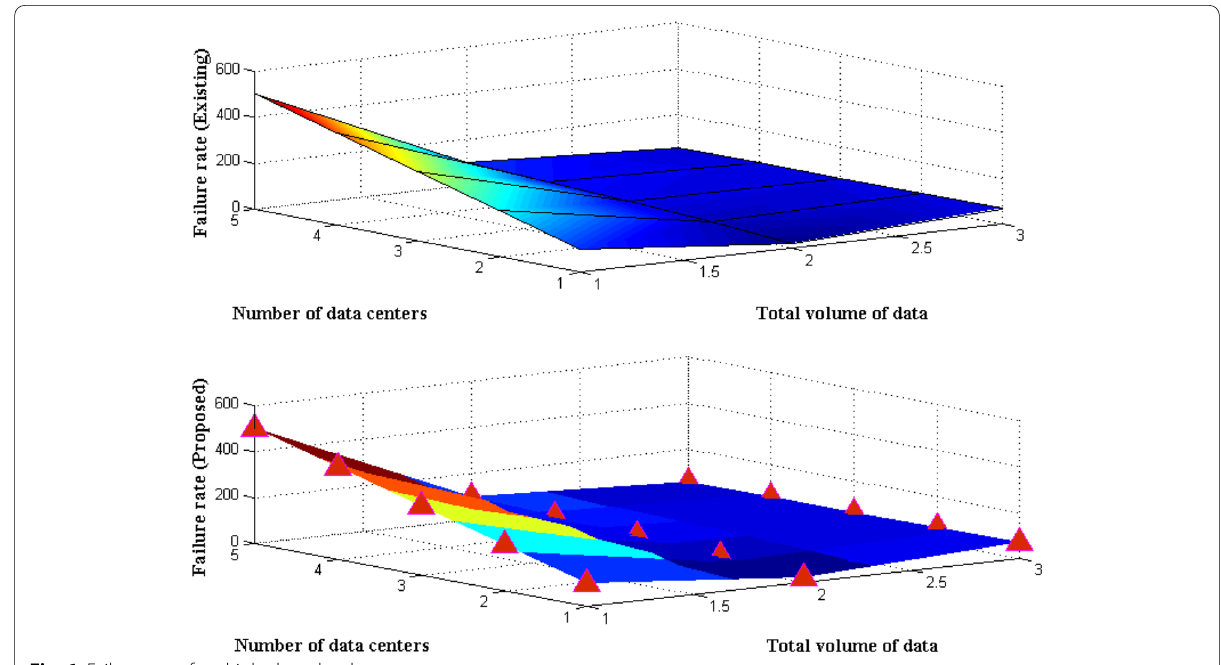
Fig. 6 Failure rate of multiple data clouds